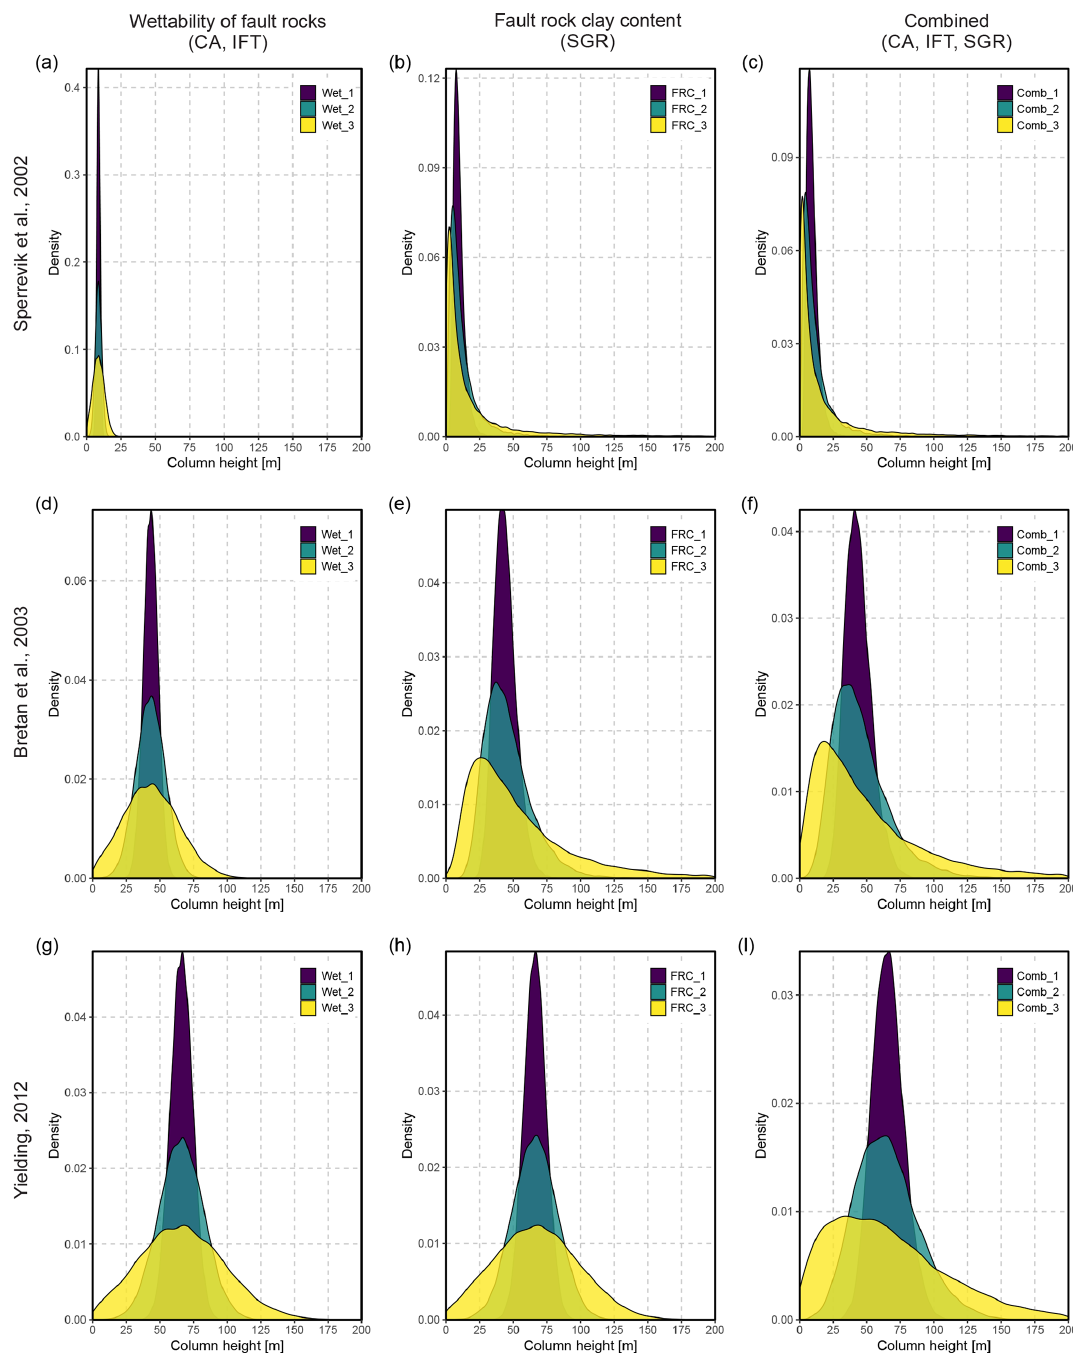
Figure 6. Density distribution of column heights of models for reservoir B (models 28 to 54). (a, d, g) The impact of uncertainties in fault rock wettability, (b, e, h) the impact of uncertainties in fault rock clay content (SGR), and (c, f, i) the impact of combined uncertainties on column heights. Each row uses a different approach to link fault rock composition to threshold pressure. Uncertainty increases from dark- to light-coloured models (Table 1). For all models N =